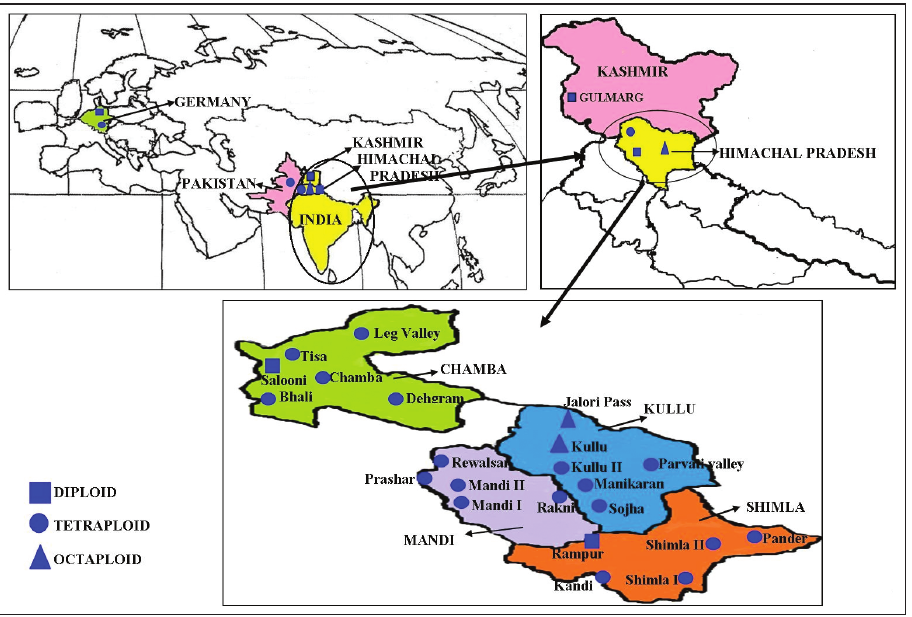
Figure 3. Geographical distribution of 2x, 4x and 8x cytotypes of Valeriana jatamansi